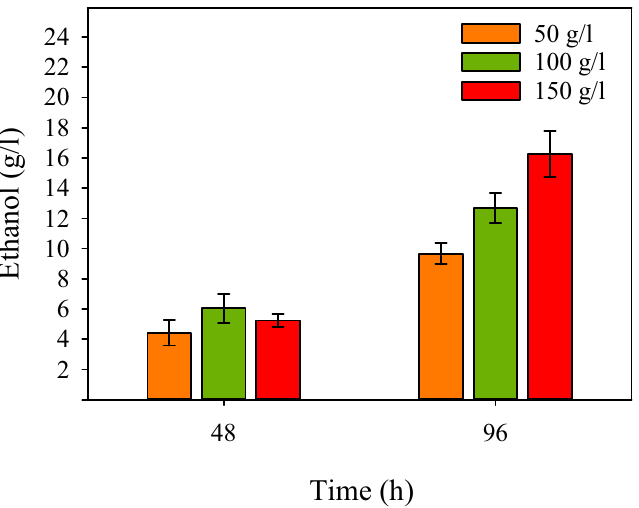
Figure 5. CBP ethanol production by strain NZS (Δ ldh , pdc Z -adh S ) using potatoes as a typical starchy biomass. Cultures were conducted in 2YT medium supplemented with 50, 100, and 150 g/L dried ground potatoes